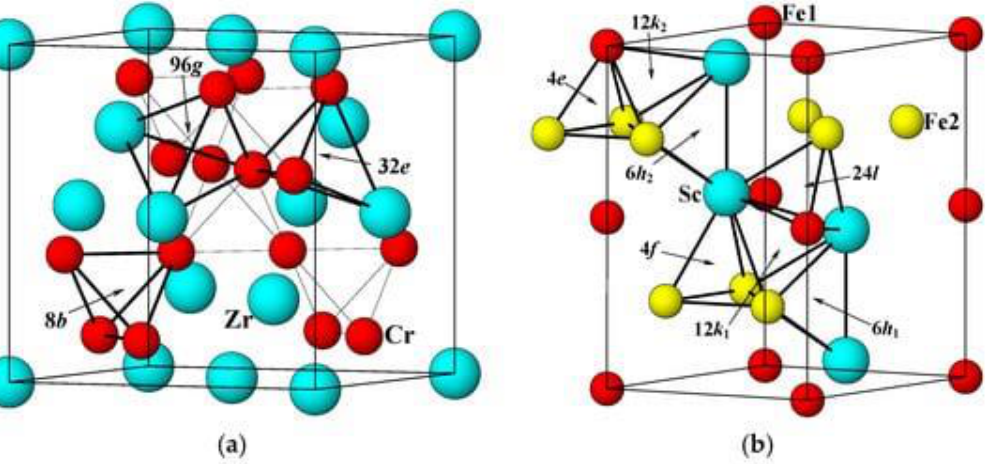
Figure 3. Elementary cells for the structures ZrCr 2 (C15) ( a ) and ScFe 2 (C14) ( b ). Various tetrahedral hydrogen filling sites (A2B2, AB3 and B4) are indicated by arrows [34].